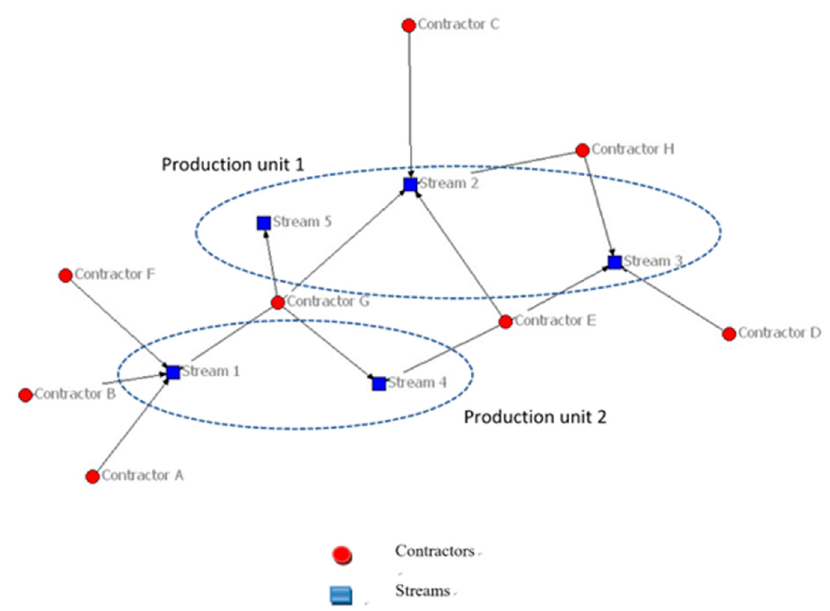
Figure 1. Contractor–Stream Relationships.